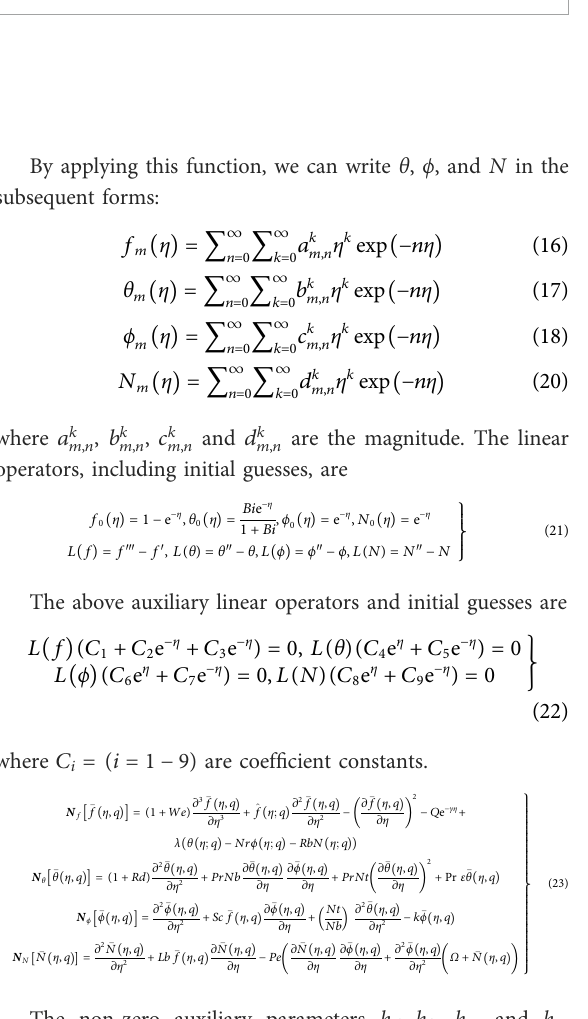
FIGURE 2 (A) Z f curvefor f ′ ( η ) ; (B) Z θ curvefor θ ( η ) ; (C) Z ϕ curvefor ϕ ( η ) ; (D) Z N curve for N ( η )